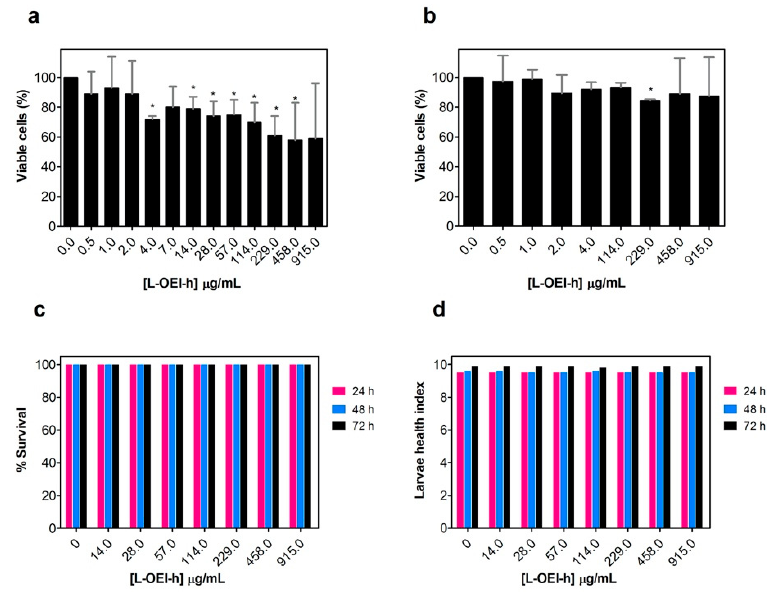
Figure 3. Evaluation of linear oligoethyleneimine hydrochloride (L-OEI-h) toxicity and biocompati- bility using in vitro mammalian cells (L929 mouse and A549 human epithelial cells) ( a , b ) and in vivo assays ( Galleria mellonella larvae) ( c ). The health index scores of wax worms injected with L-OEI-h was also evaluated ( d ). Asterisks (*) represent statistical significance in t -student tests ( p < 0.05) compared to the untreated samples.